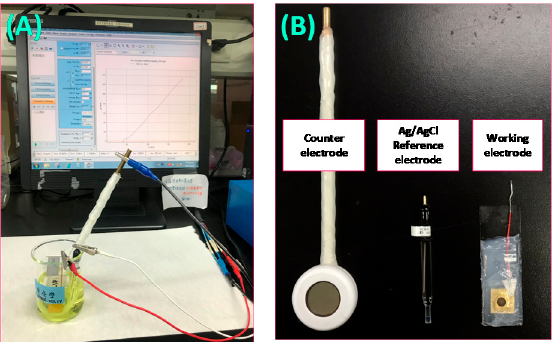
Figure 1. The analysis system: ( A ) experimental setup; ( B ) electrodes for the experiment.